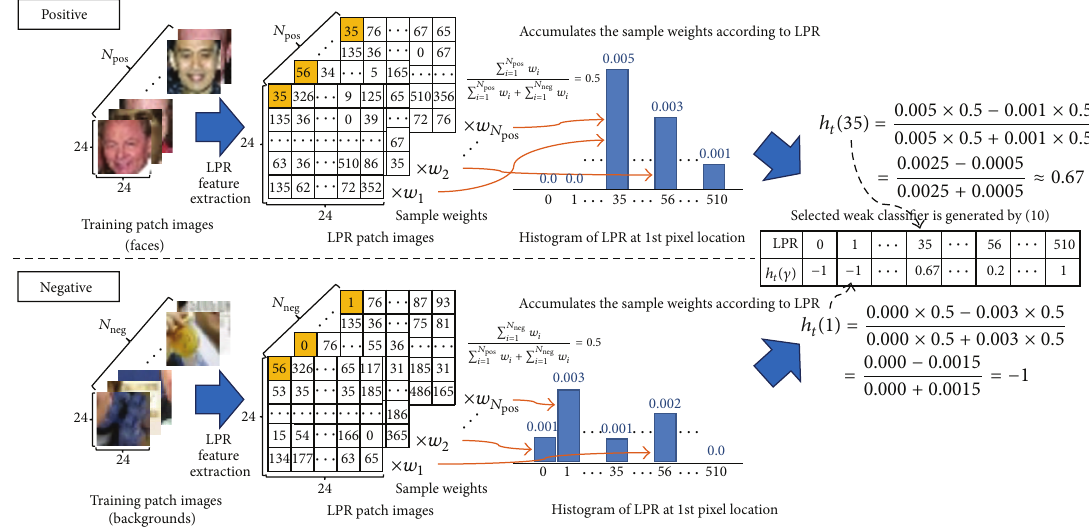
Figure 4: Selection of weak classifier for each round in AdaBoost learning. At first, LPR images are extracted from the training images. The histogram of LPR is generated by accumulative weights of samples according to the LPR feature values of the same pixel location. Assuming that the 1st pixel location is the best pixel location with the smallest error rate, it can be selected as a weak classifier for that round in AdaBoost learning. The selected weak classifier is described as a lookup table which is generated by (8), and the real values in the lookup table represent the confidence level of prediction.